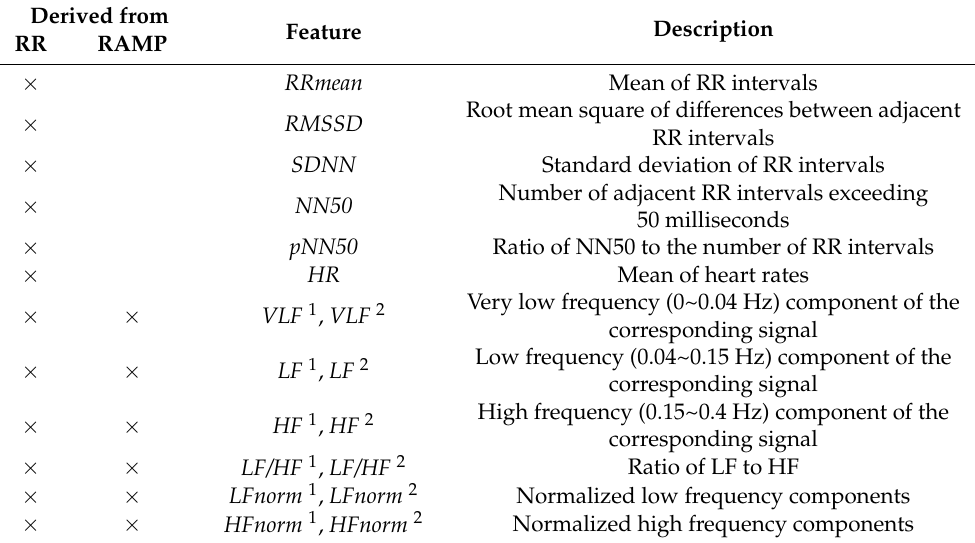
Table 1. RR intervals features and R-wave Amplitudes